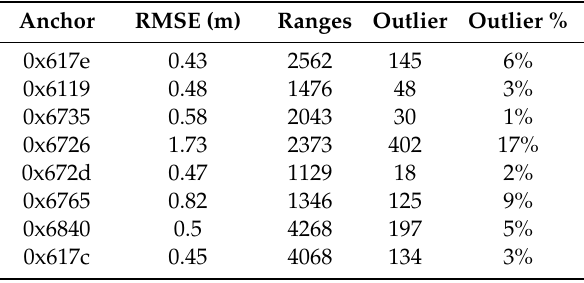
Table 4. Ranges RMSE and % of outliers for each